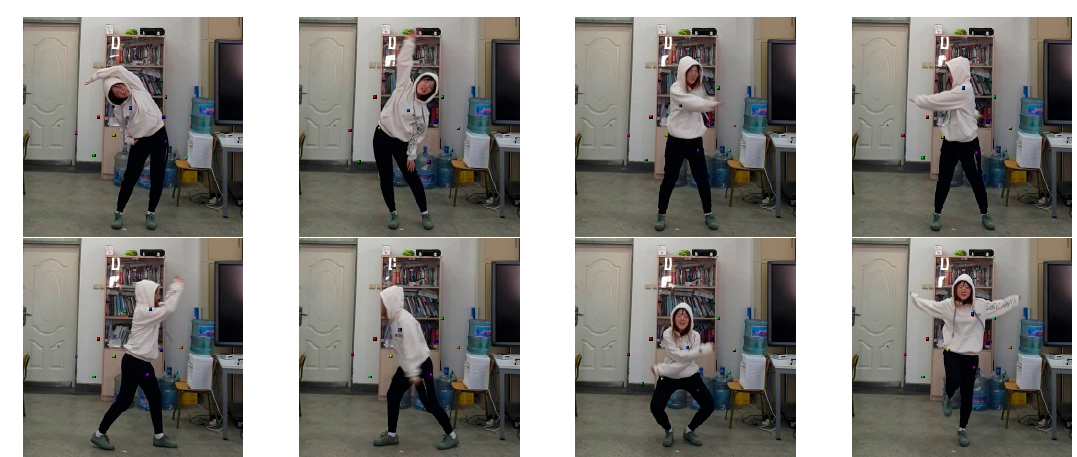
Figure A5. 2D landmarks generated when κ was 10 using RGB images.